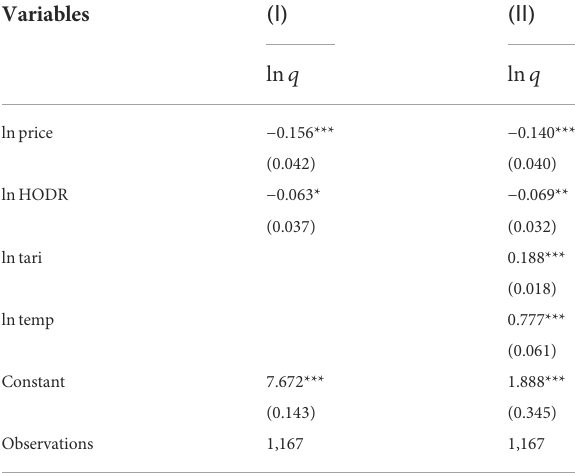
TABLE 3 OLS estimation results of annual household electricity consumption. Variables